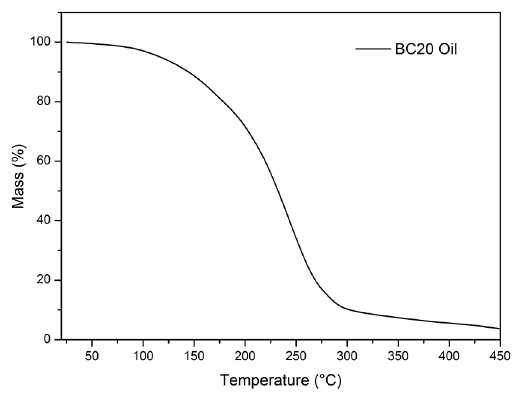
Figure 2: TGA curve of BC20 machining oil. to the mass of the samples of this study, a maximum limit of 250 ppm (0.0025 mg). Ethylene oxide remaining above this limit is not considered safe for living beings 17 . In this study, it was observed that the remaining oxide in the sterilized, non-aerated hyperventilated samples was higher than that allowed by ANVISA and that the sensitivity of the